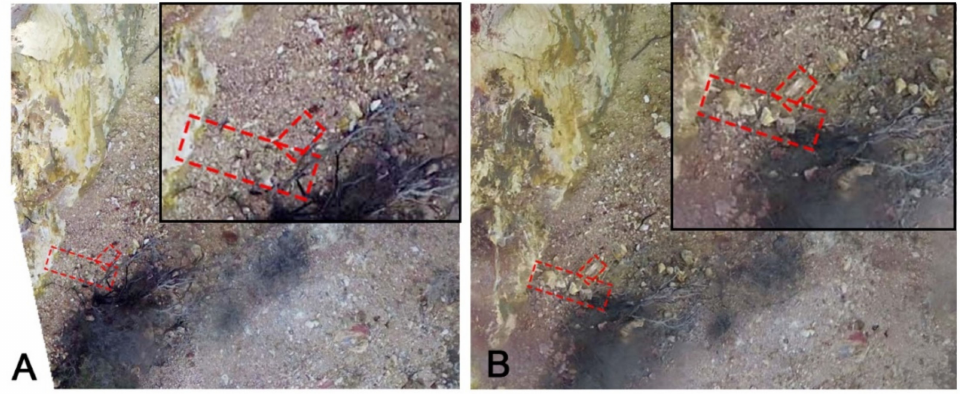
Figure 7. Evidence of the rockfall that occurred between November ( A ) and December ( B ).